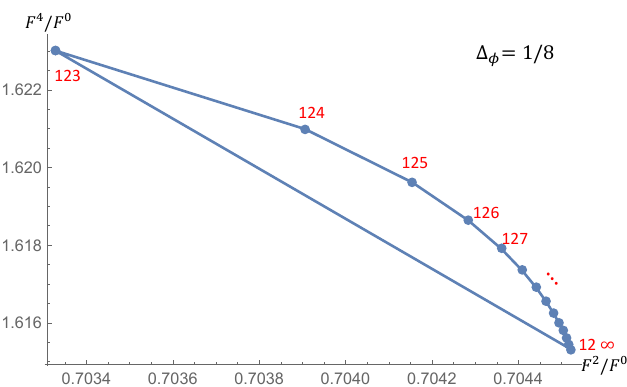
Figure 20 . The cyclic polytope projected onto the crossing plane for the free fermion spectrum (cid:1) i = 2(cid:1) (cid:30) + 2 i 1 ( i = 1 ; 2 ; ). The dimension (cid:1) (cid:30) of the external operator (the fermion (cid:12)eld) is (cid:0) (cid:1) (cid:1) (cid:1) shown in the